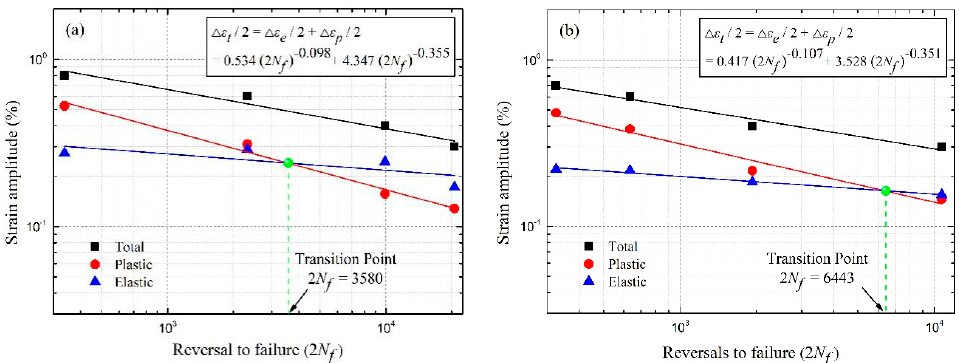
Figure 9. Strain amplitude vs. reversals to failure curves for ( a ) as-received sample; ( b ) aluminized sample.